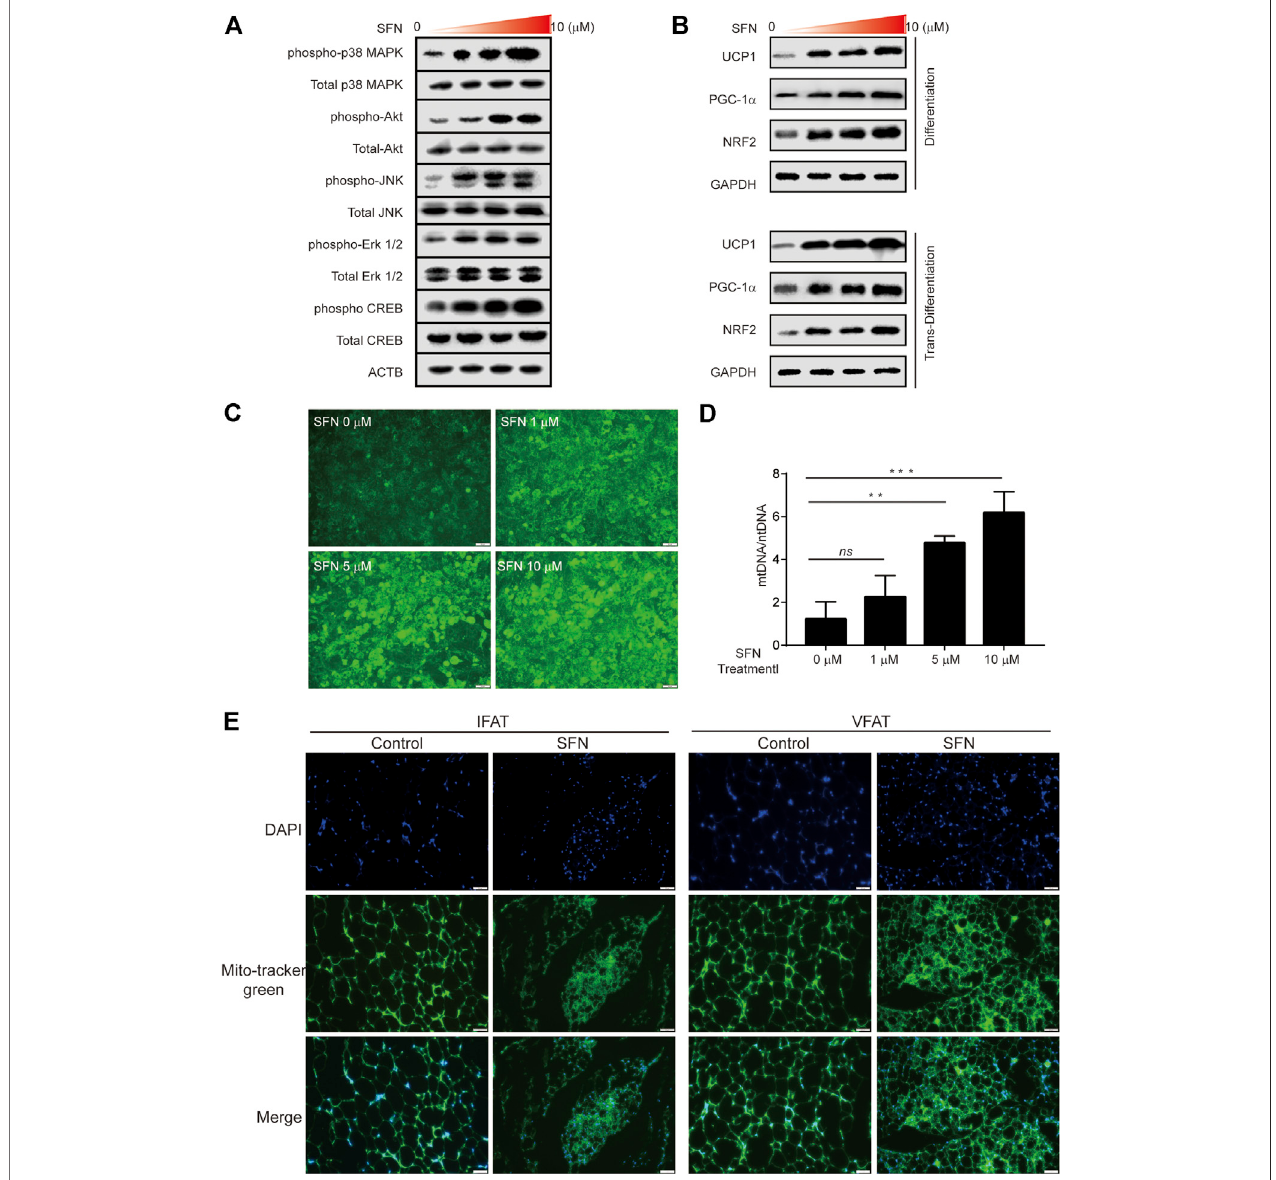
FIGURE 8 | SFN promoted the browning of adipocytes through mitochondrial biogenesis. (A) SFN activated the MAPK and PKA – CREB pathway. (B) SFN promoted the expression of UCP1, PGC-1 α , and NRF2 in the adipocyte differentiation and trans-differentiation periods. (C) Distribution of adipocyte mitochondria as assessed by MitoTracker Green staining. (D) The copy number of mtDNA per adipocyte was assessed by real-time qPCR. (E) . Scar bar (cid:2) 50 μ m. The content of adipocyte mitochondria assessed by MitoTracker Green staining in the adipose tissue section of HFD-induced mice. All the results were expressed in graph with mean ± SD.Statisticalsigni fi cancewasevaluatedbyANOVAtest.*,**and***representthesigni fi cantdifferenceat p < 0.05, p < 0.001and p < 0.0001. ns representnot signi fi cant.